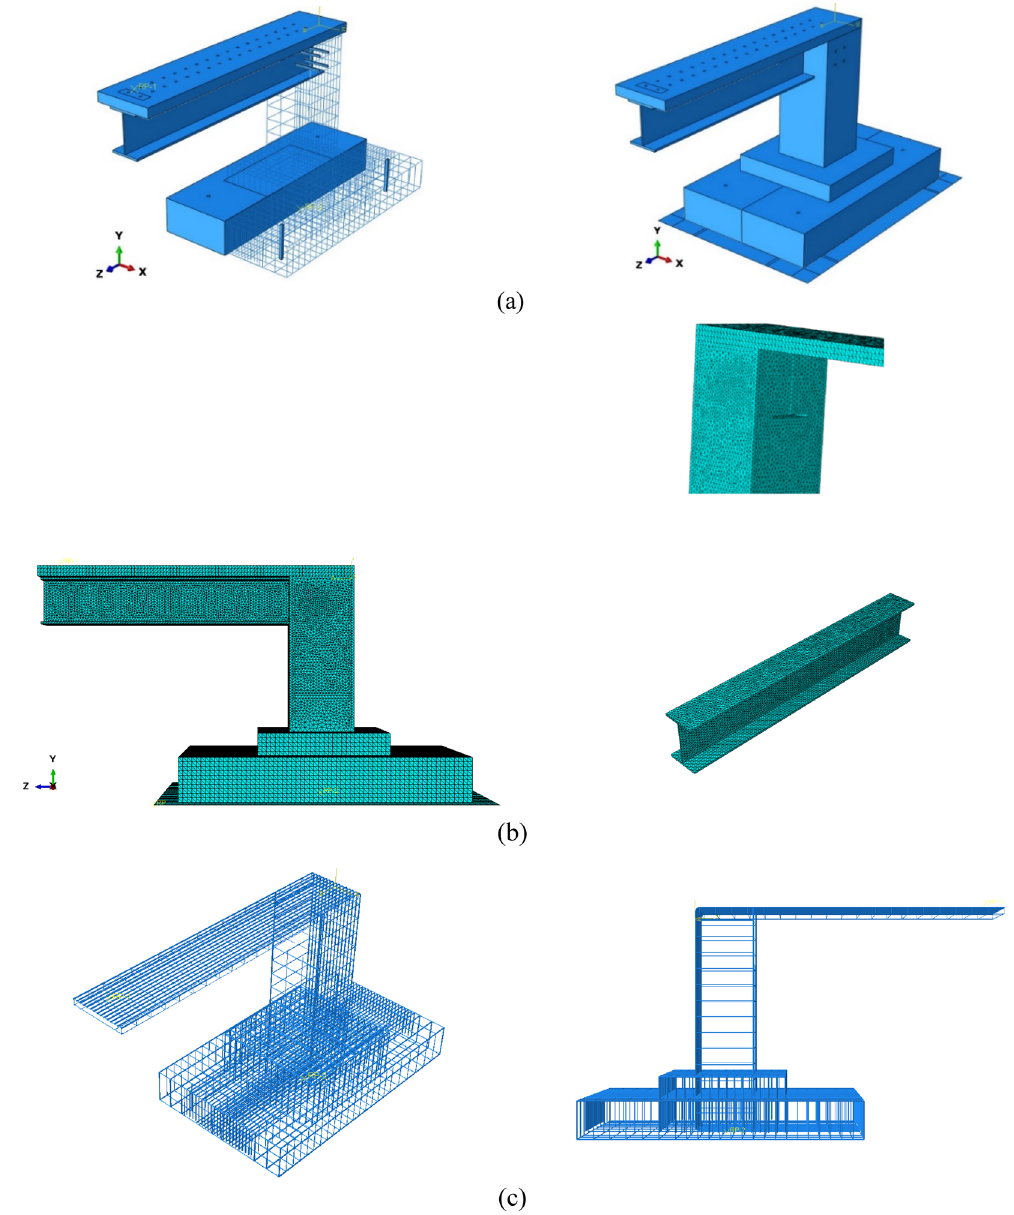
Figure 9. Numerical details of the model: ( a ) model components, ( b ) Meshing, ( c ) Reinforcement